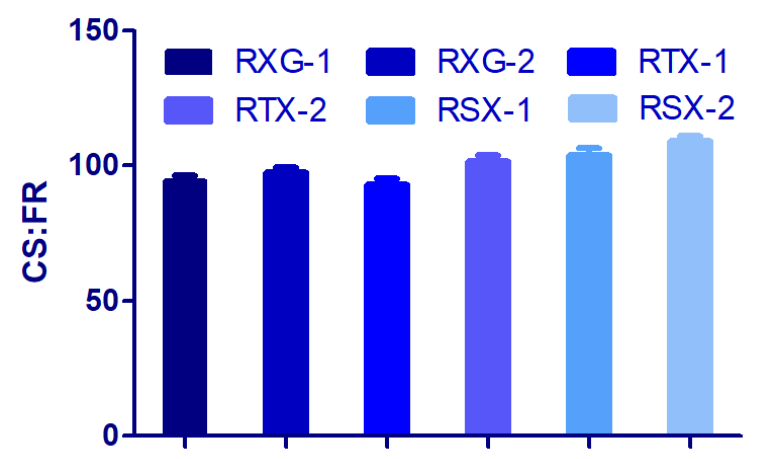
Figure 6. Assessment of the CSFR for prepared batches.